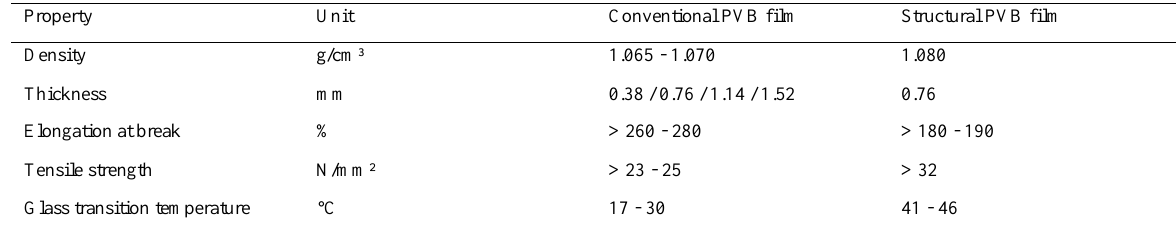
Table 1: Comparion of typical properties of conventional and structural PVB films